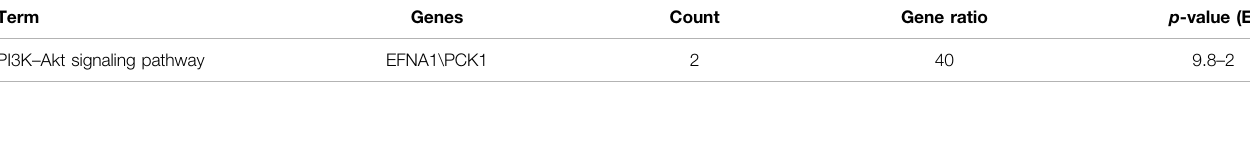
TABLE 3 | The result of the KEGG pathway enrichment analysis. Term